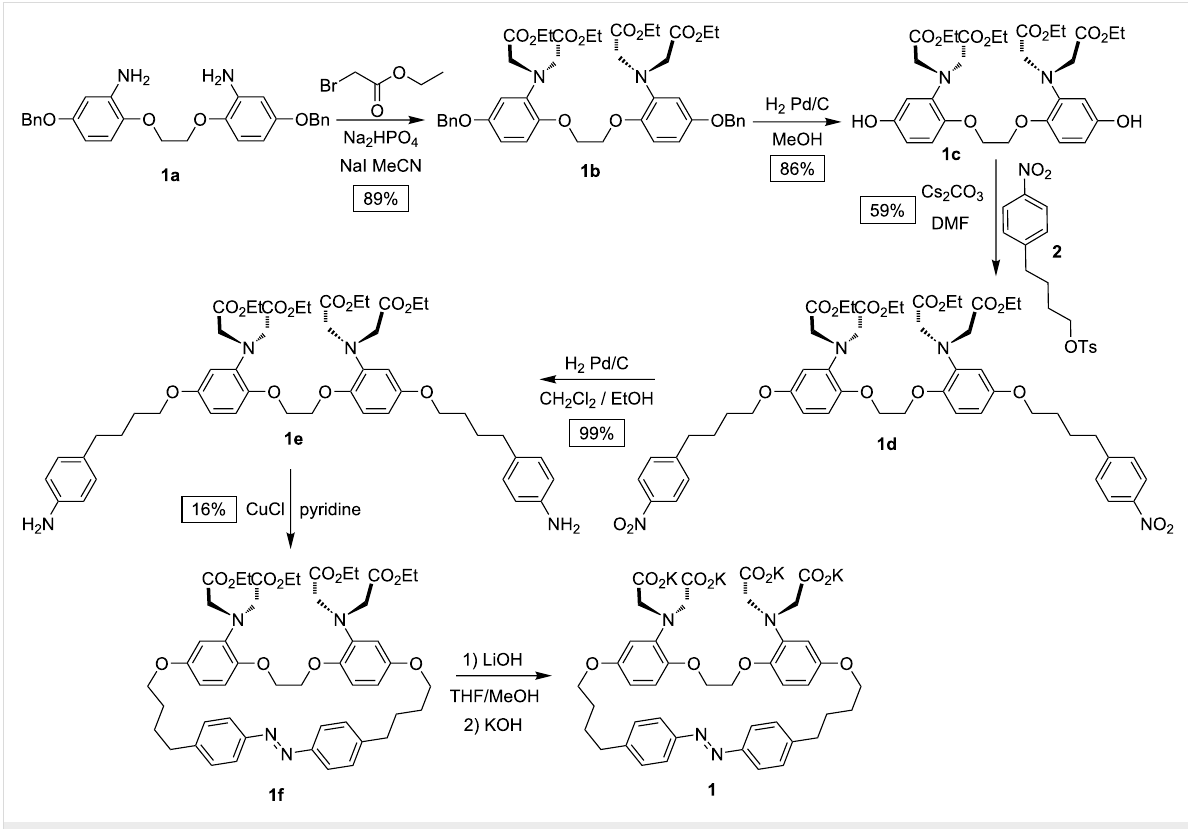
Scheme 1: Synthesis of azobenzene-tethered BAPTA 1 .